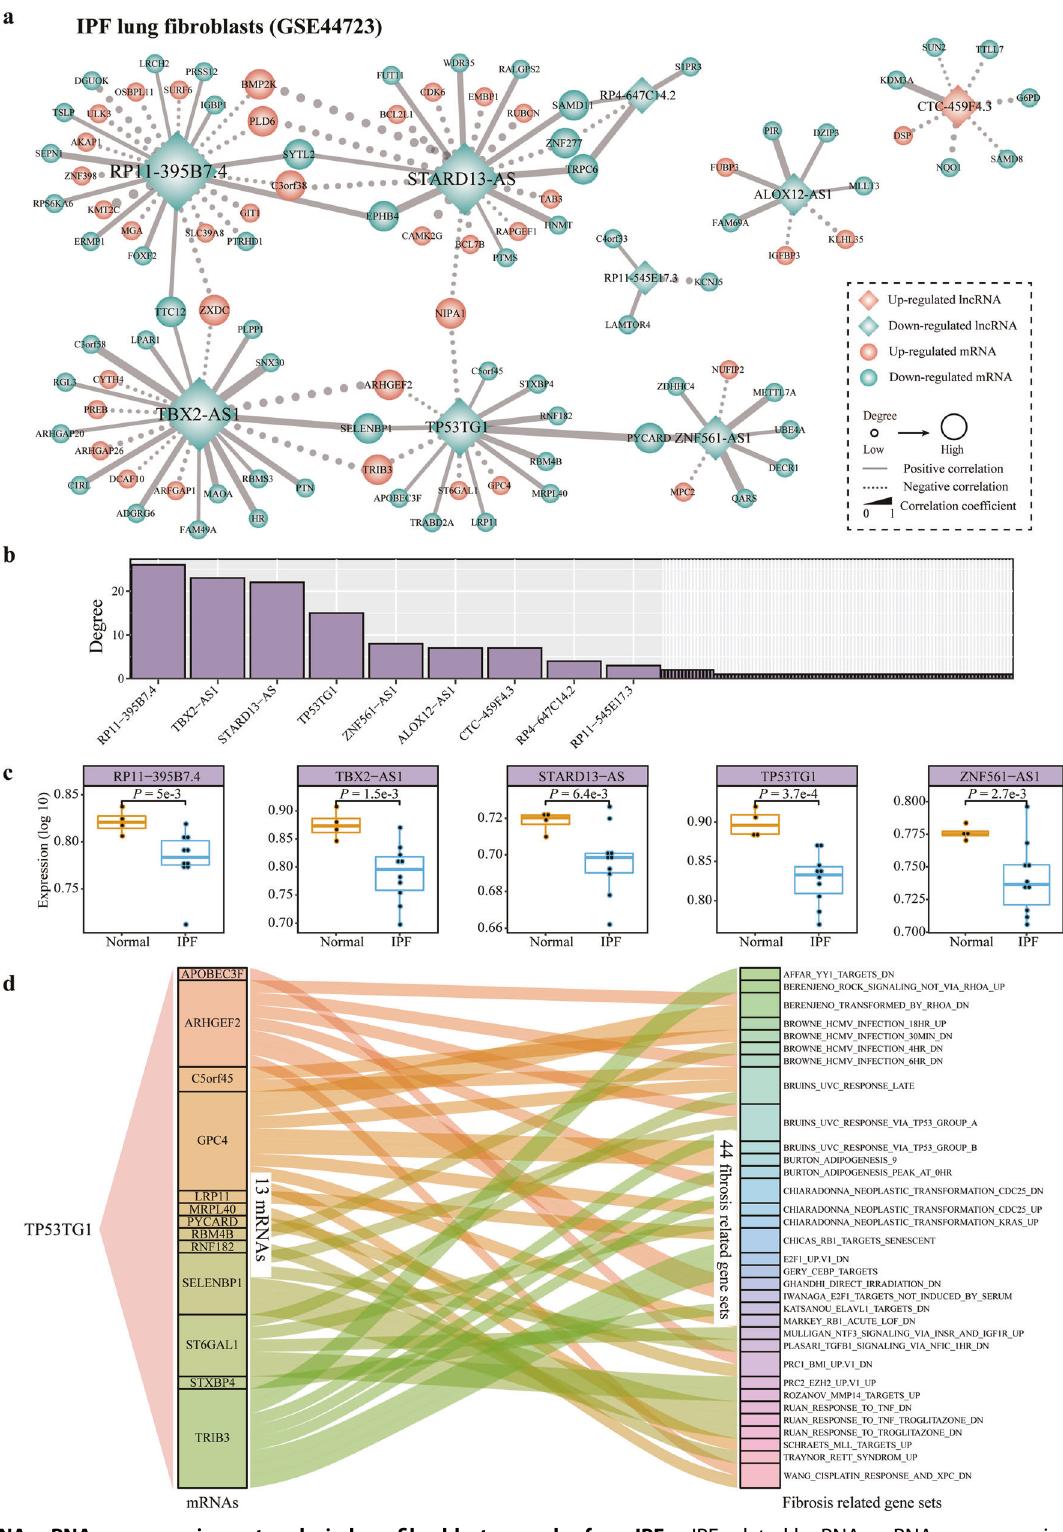
Fig. 3 LncRNA-mRNA co-expression networks in lung fi broblasts samples from IPF. a IPF-related lncRNAs-mRNAs co-expression network in GSE44723. The diamond and round nodes are lncRNAs and mRNAs, respectively. Nodes marked with orange color represent the up-regulated IPF-related genes. The nodes marked with green color represent the down-regulated IPF-related genes. The size of nodes represents the degree and the line thickness of the edges indicates the strength of correlation. The solid lines (dotted lines) represent the positive (negative) correlation between mRNAs and lncRNAs (|r| > 0.8, P -value < 0.01, Pearson Correlation Test). b Distribution of the degree of genes in the IPF- related network (genes with degree greater than three were shown). c The expression of the fi ve genes in IPF compared to normal lung. The Student ’ s t -test was used to determine the statistically signi fi cant differences between two groups. d Sankey diagrams display the connection between TP53TG1 correlated mRNAs and fi brosis-related gene sets in IPF. Cell Death and Disease (2022)